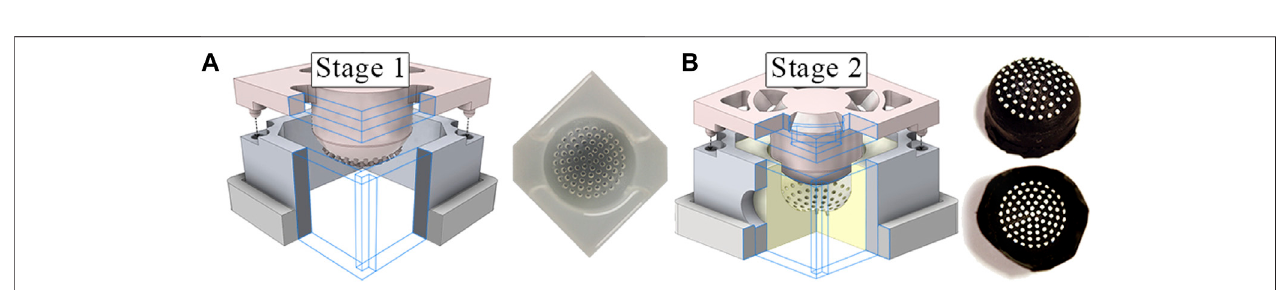
FIGURE 3 | (A) Two step molding process to form the tactile membrane using 3D printed molds. The clear negative mold, formed in the fi rst stage, is used in the second stage to form the inverted tactile membrane. (B) Lastly, the membrane is fl ipped ‘ inside-out ’ and the pin tips are painted white.